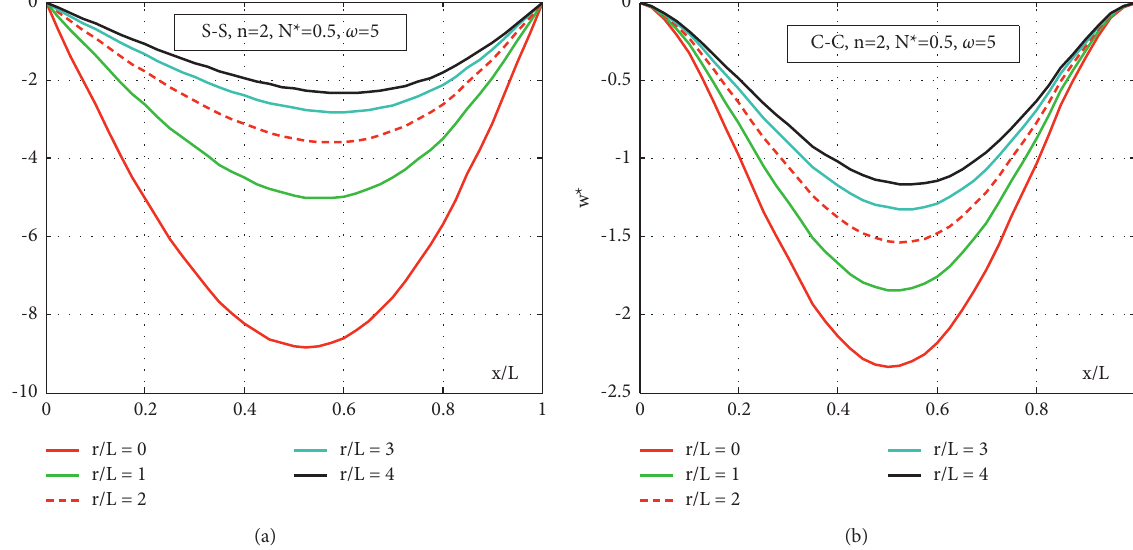
� 20, K ∗ � 5, and α � 0.2. (a) S-S. (b) w s